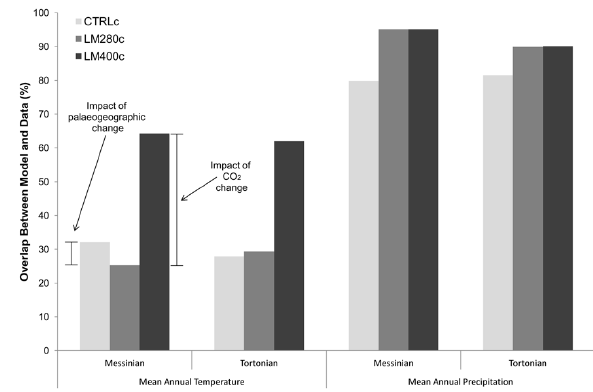
Fig. 17. Model–data comparison summary for MAT and MAP. Shown is the percentage of the total number of datapoints that over- lap with the model results.